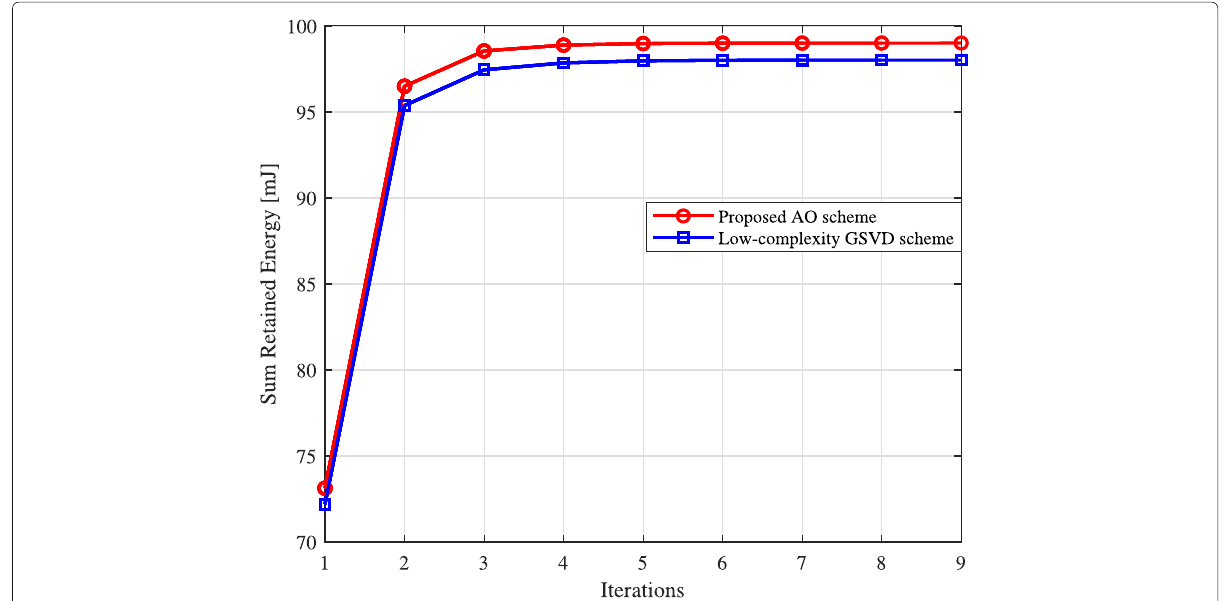
Fig. 3 Sum retained energy versus the number of